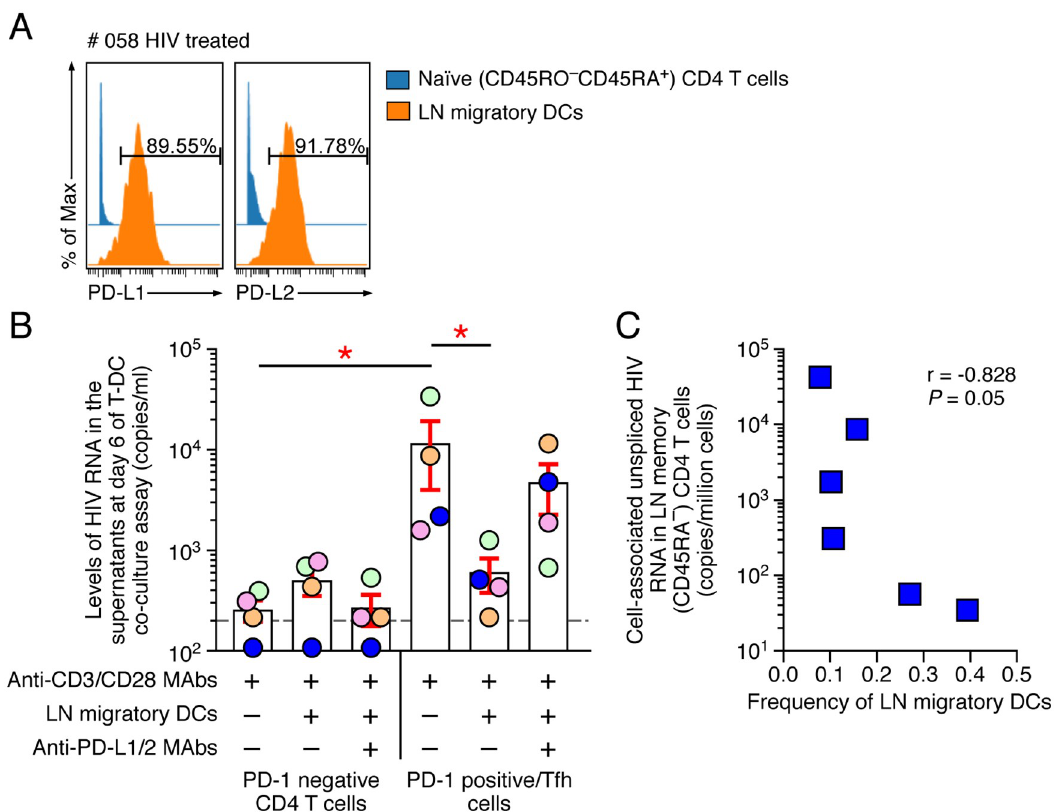
Fig 5. LN migratory dendritic cells expressing PD-L1 and/or PD-L2 modulate HIV-1 transcription/production in LN of treated aviremic HIV-infected individuals. (A) Level of expression of PD-Ls on LN (CD1c high CCR7 + CD127 + ) migratory DCs from one representative aviremic ART treated HIV-infected individual (#058). (B) Cumulative data of the levels of HIV-1 RNA (copies/ml) in the culture supernatants at day 6 of LN PD-1 - or PD-1 + CD4 T cells following anti-CD3/anti-CD28 stimulation and co-culture with autologous LN migratory DCs in the presence or absence of blocking anti-PD-L1/L2 MAbs (N = 4). (C) Correlation between the levels of cell-associated unspliced HIV-1 RNA detected in LN memory (CD45RA - ) CD4 T cells and the frequencies of LN migratory DCs in aviremic ART treated HIV-infected individuals (N = 6). HIV-infected individuals were color-coded (B) . Red stars indicate statistical significance ( P < 0.05). Statistical significance ( P values) was obtained using one-way ANOVA (Kruskal-Wallis test) followed by ratio Paired-t test (B) or using Spearman rank test for correlations (C)